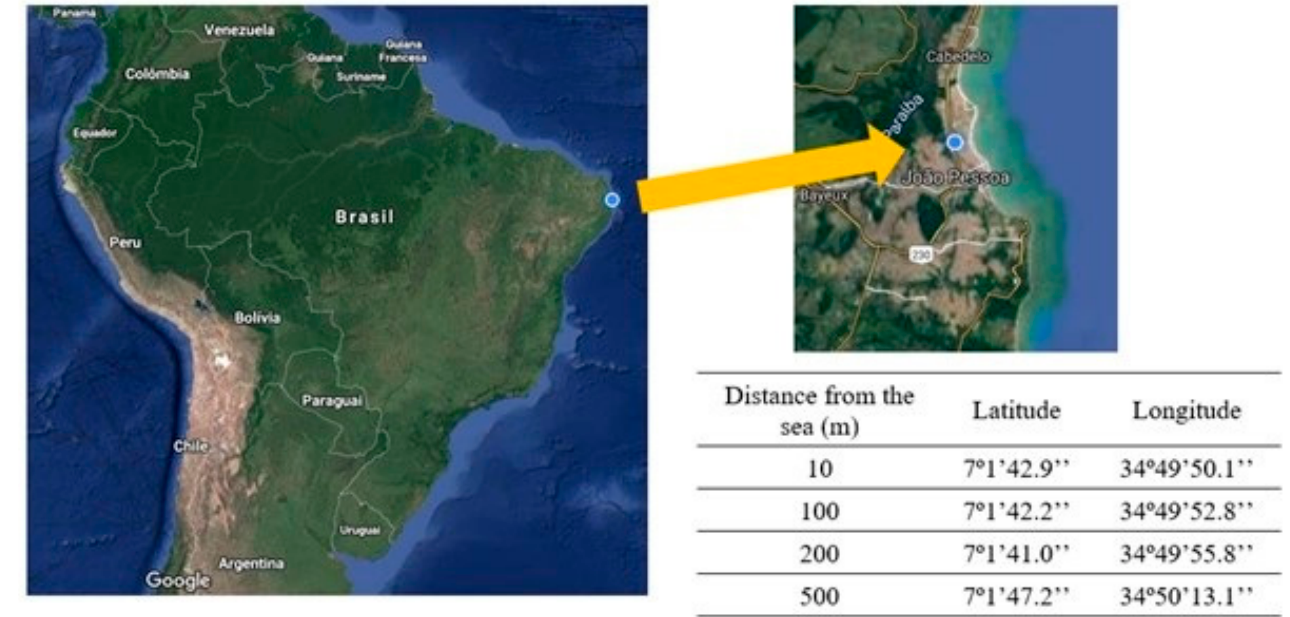
Figure 2. Region where wet-candle devices and concrete specimens were exposed. Table 2. Chemical and physical properties of studied cement.